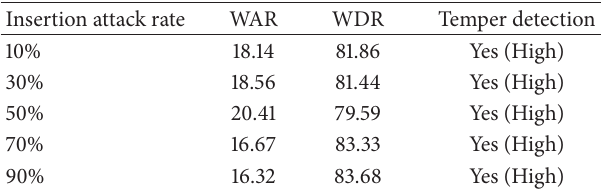
Table 2: Detection of malicious insertion of tuples with different attack rates ( 𝜂 = 10 6 ).